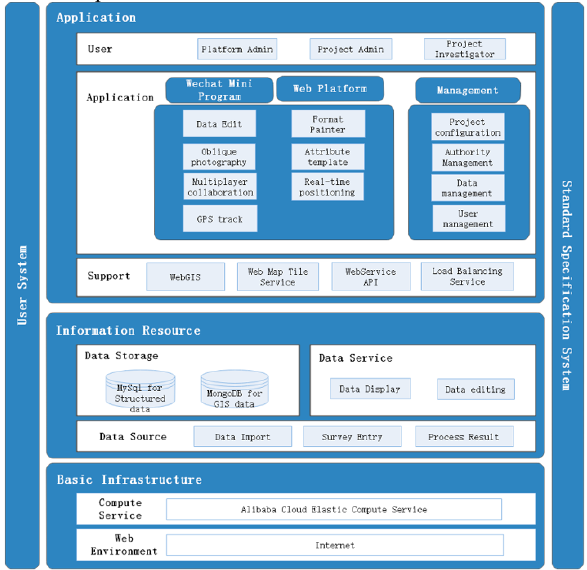
Figure 1 . The System Architecture of Yingshao